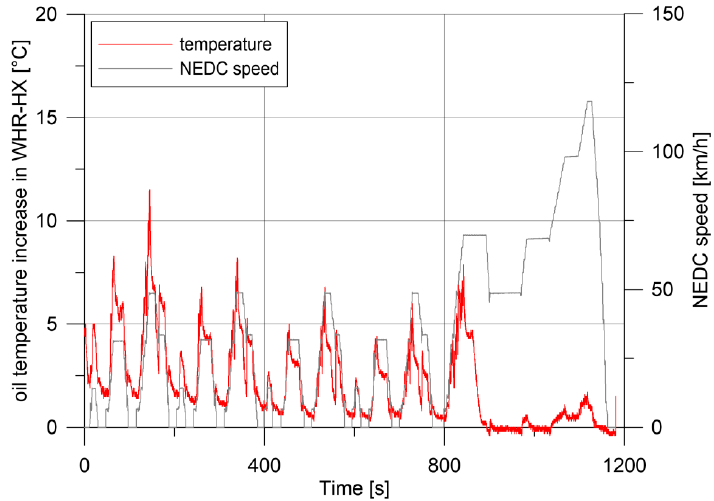
Figure 8. Oil temperature increase in the WHR-to-oil heat exchanger.